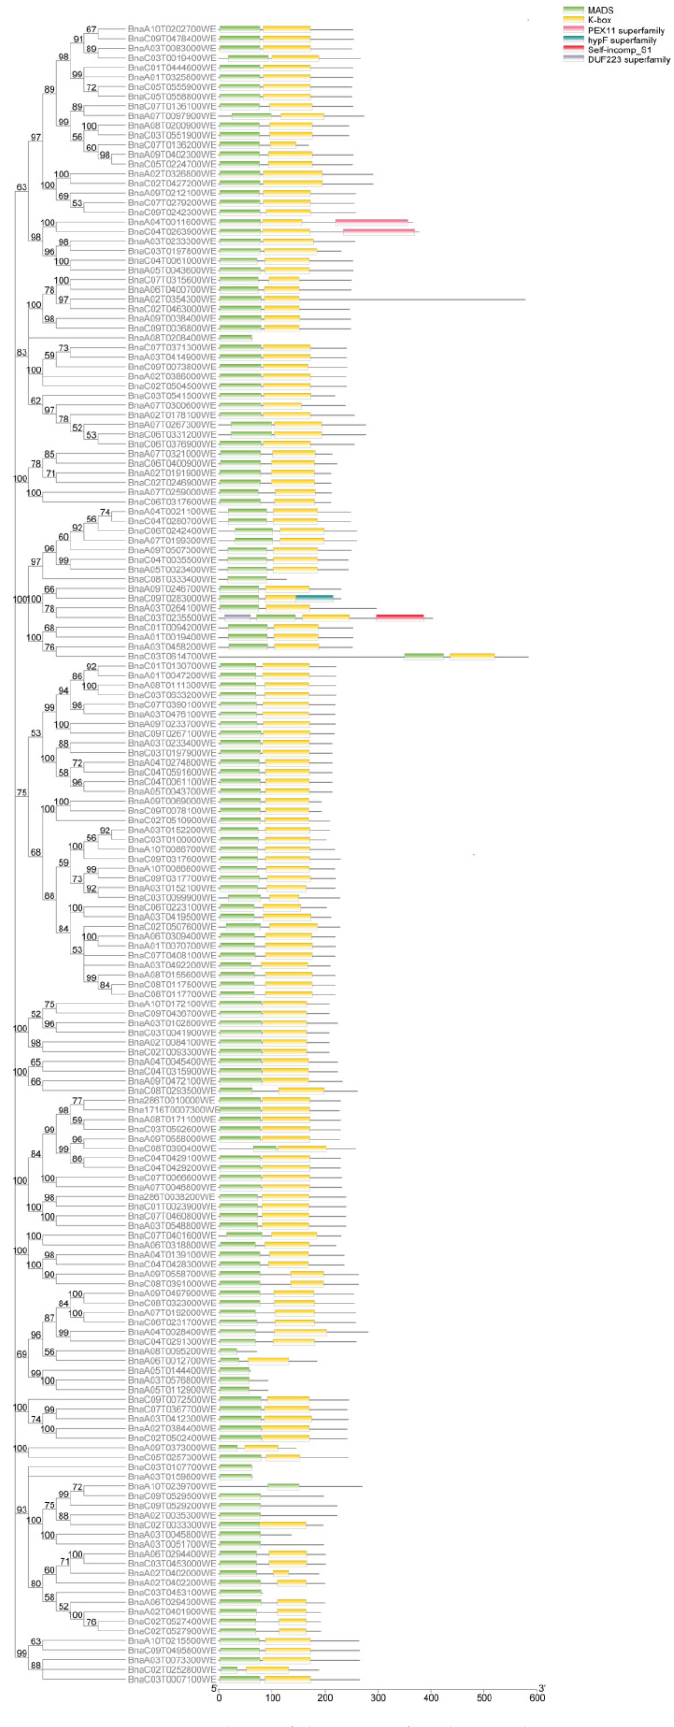
Figure 3. Domain analysis of the MIKC family members.